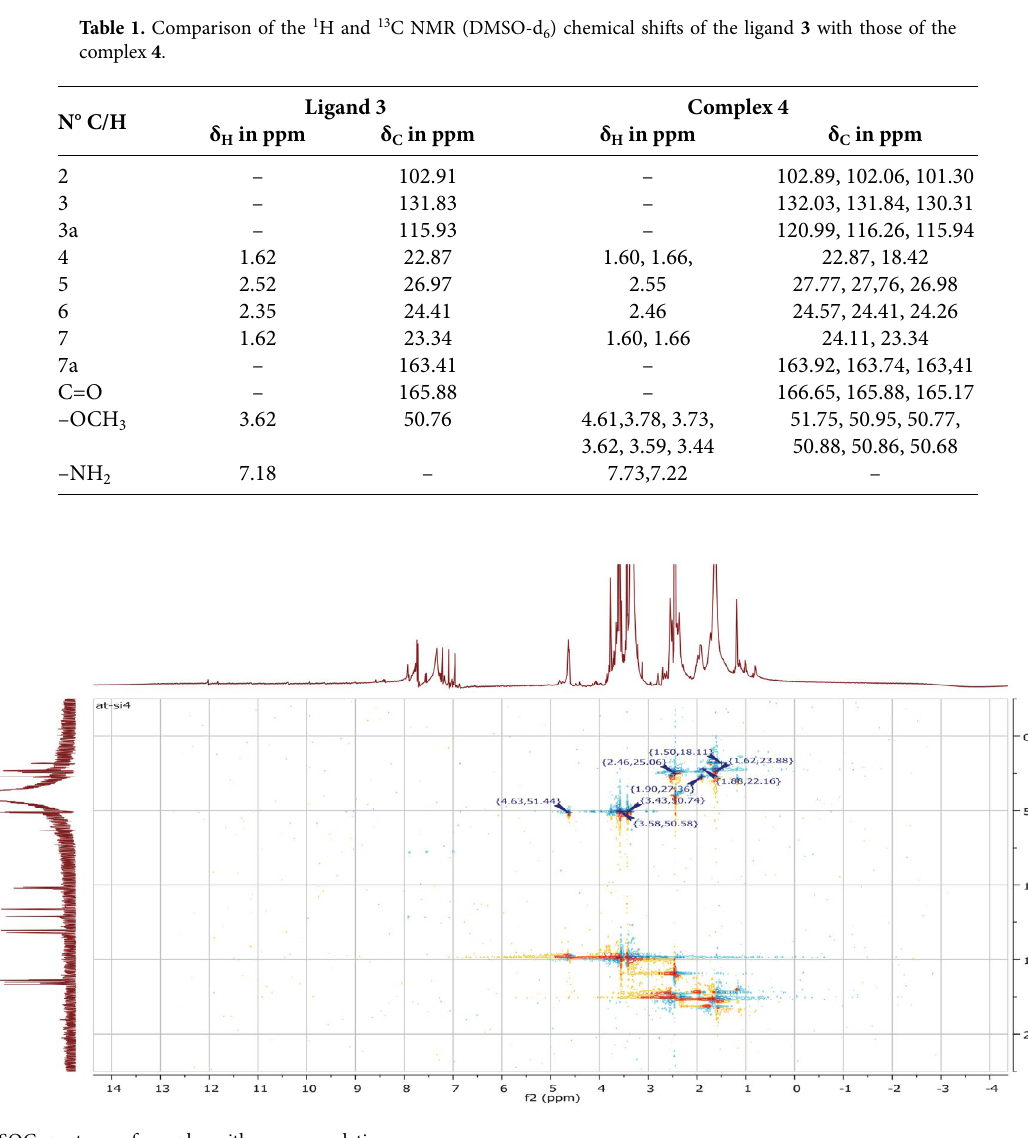
Figure 1. HSQC spectrum of complex with some